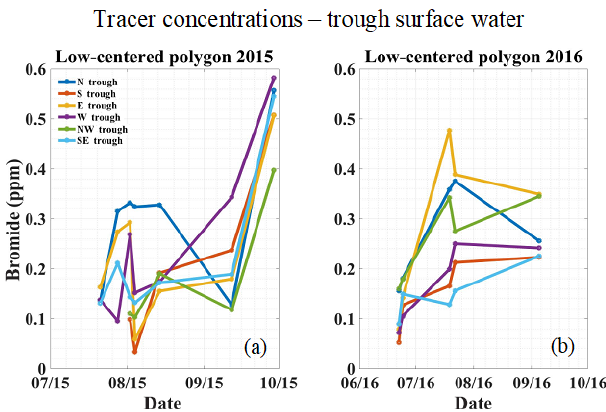
Figure 10. Breakthrough curves sampled from the surface waters in polygon troughs for (a) low-centered polygon in 2015 and (b) low- centered polygon in 2016. Notice the upward trend in tracer con- centration in the troughs of the low-centered polygon (a) during the 2015 thaw